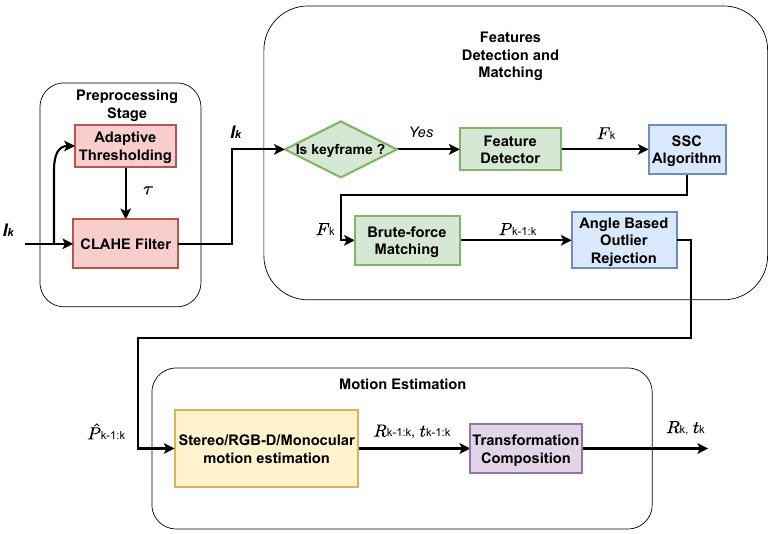
Figure 1. Proposed pipeline for the robust feature-based VO with the added filtration stages high- lighted in